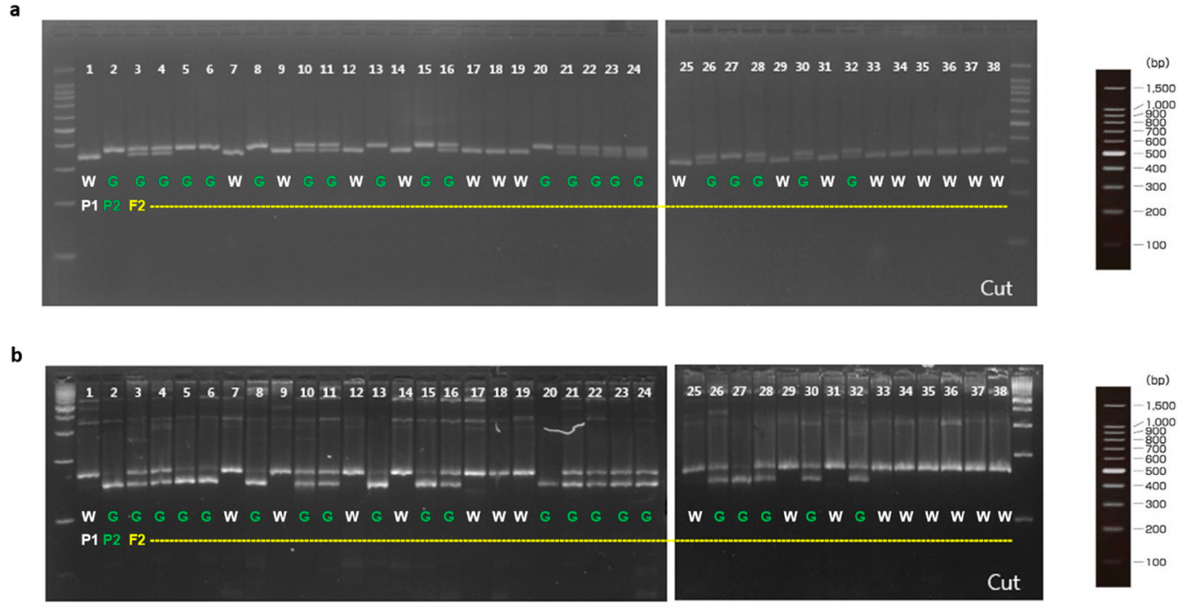
Figure 4. dCAPS analysis of novel alleles in the F 2 plants derived from a cross between MEJ and PI525075. P1, ‘PI525075’ (white); P2, ‘MEJ’ (light-green); W, white; G, light-green. ( a ) M7 marker for a novel allele of Chr3CG52930 ; ( b ) M8 marker for a novel of allele of Chr3CG53640 .